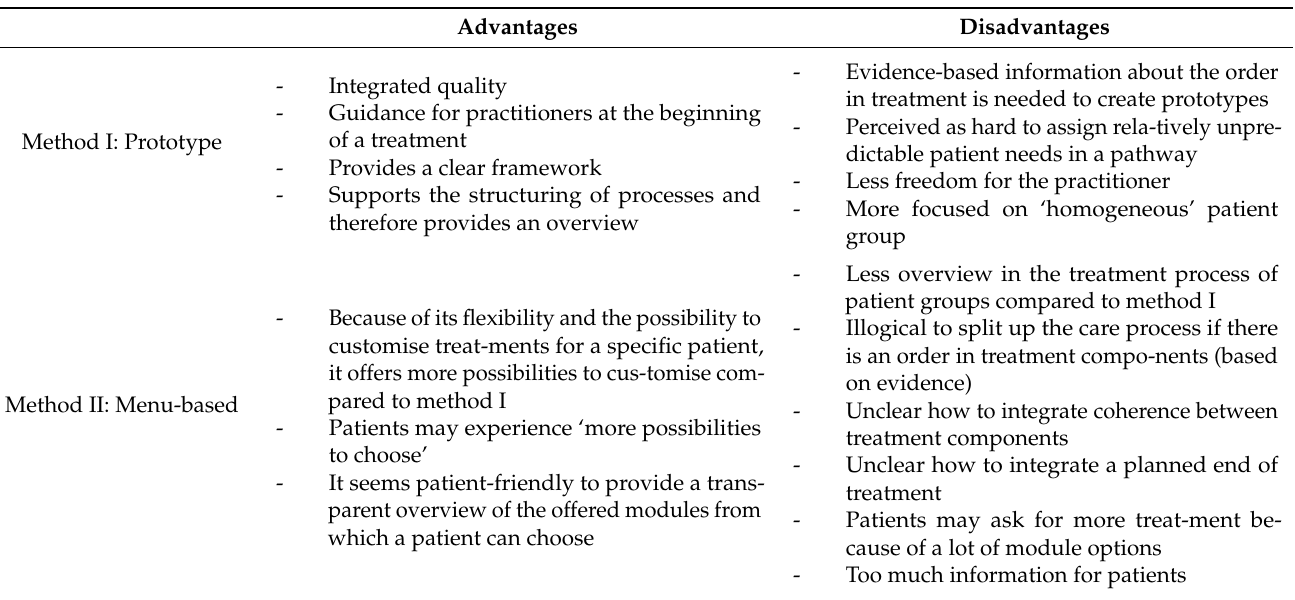
Table 1. Review prototype and menu-based